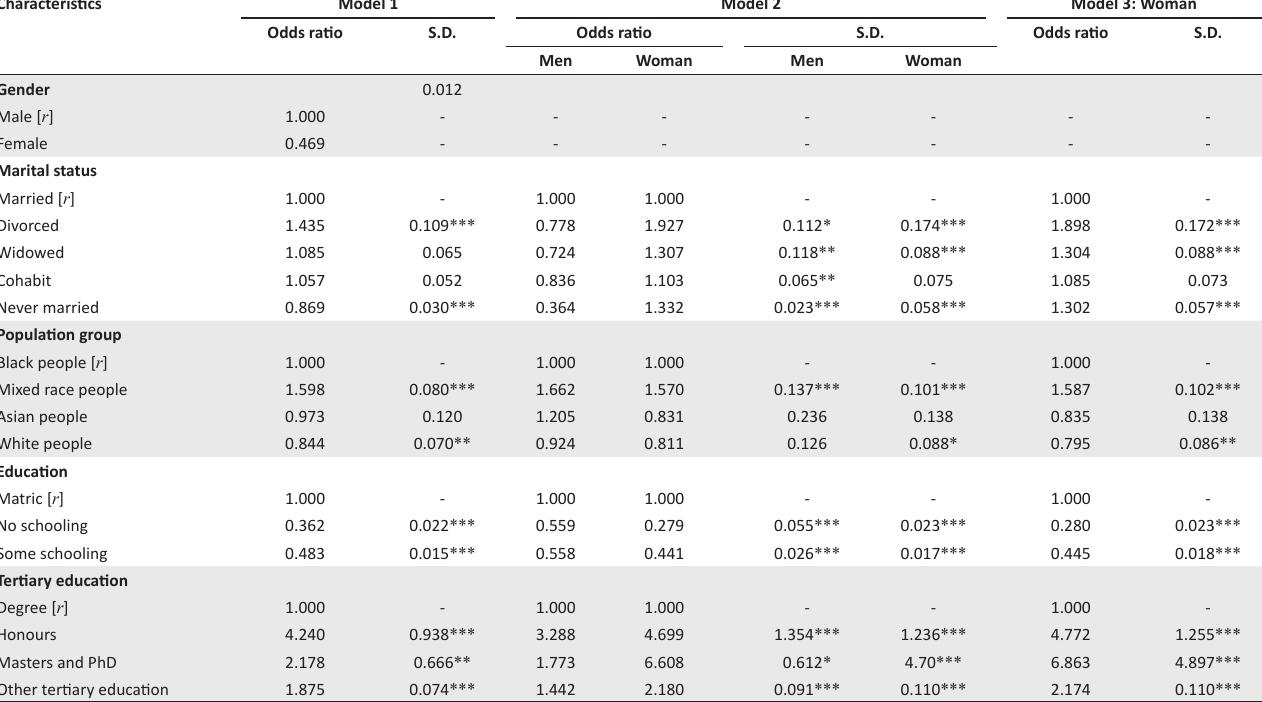
TABLE 6: Employment logistic regression